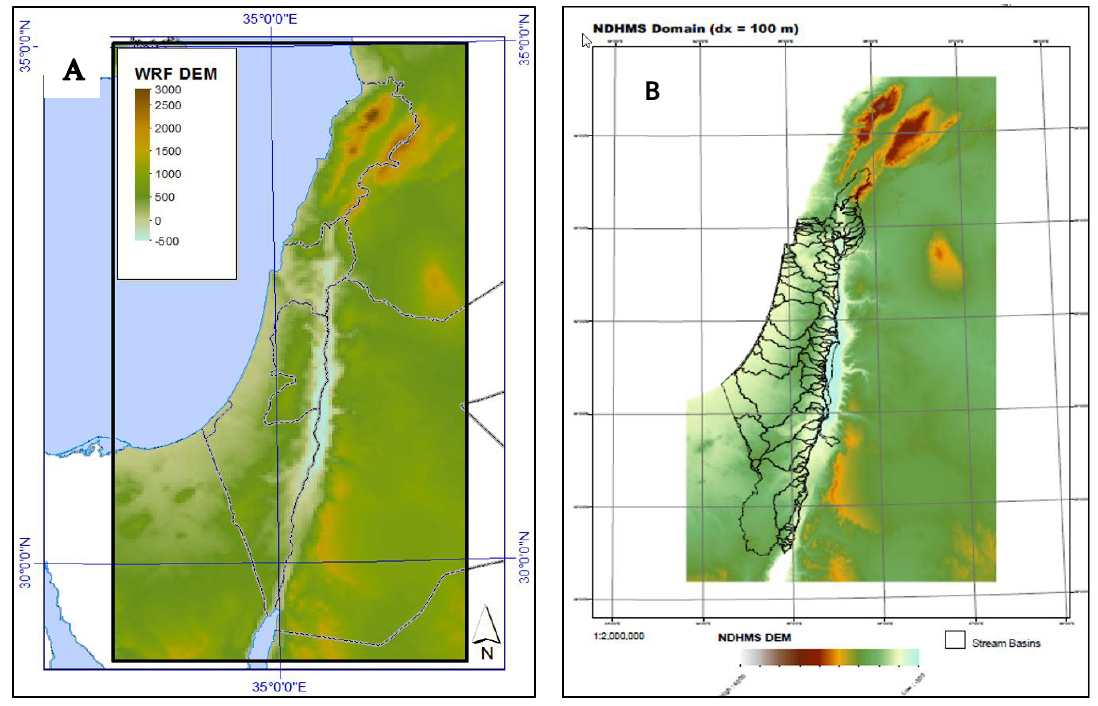
Figure 2. The WRF-Hydro domain and topography ( A ) and main watershed in the domain ( B ).